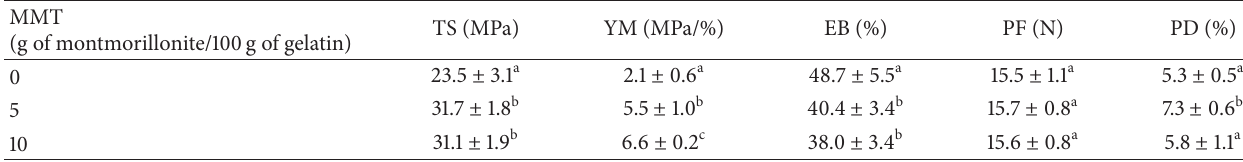
Values with different characters differ significantly in the same column ( 𝑝 < 0.05 ). Table 3: Glass transition temperatures, enthalpy, and fusion temperature for nanocomposites prepared with 5 g of gelatin/100 g of NFS and different MMT concentrations and stored under 58% of RH. MMT (g of montmorillonite/100g of gelatin)